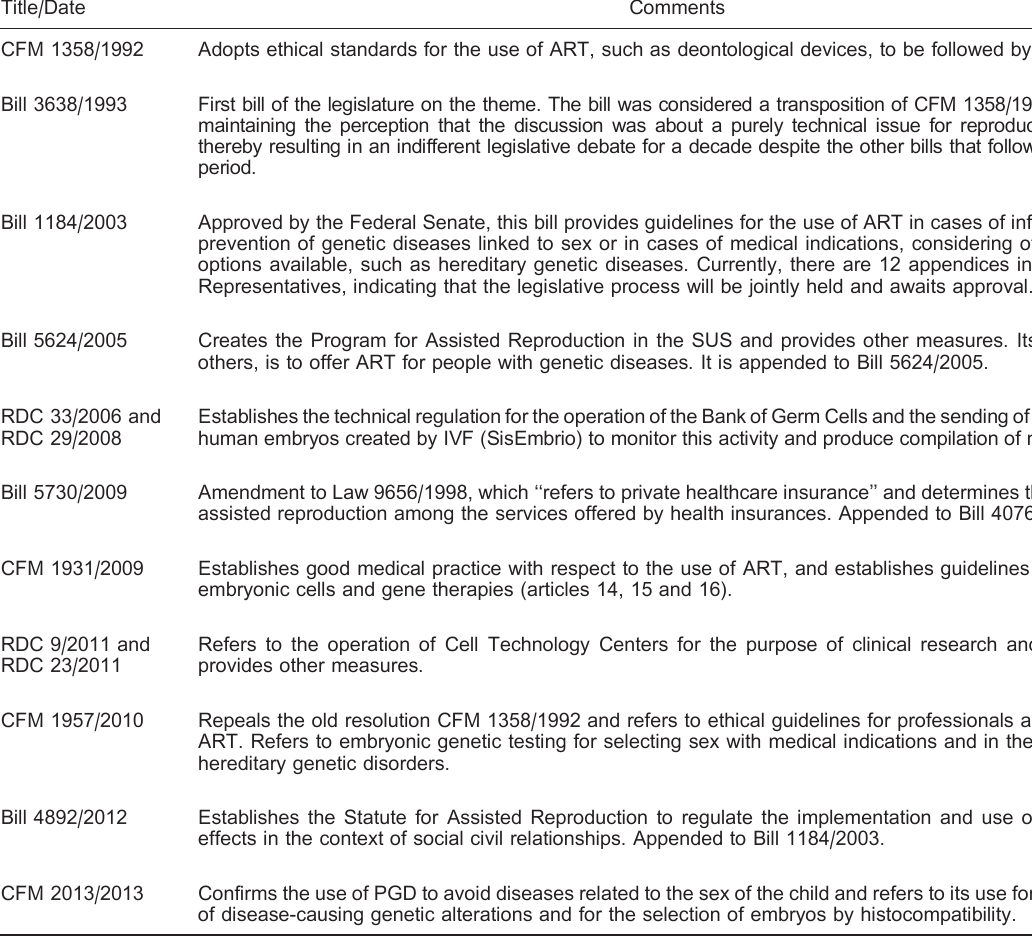
Table 2. Major legislation and other proposals aimed at assisted reproduction techniques (ART) in the context of hereditary genetic diseases in